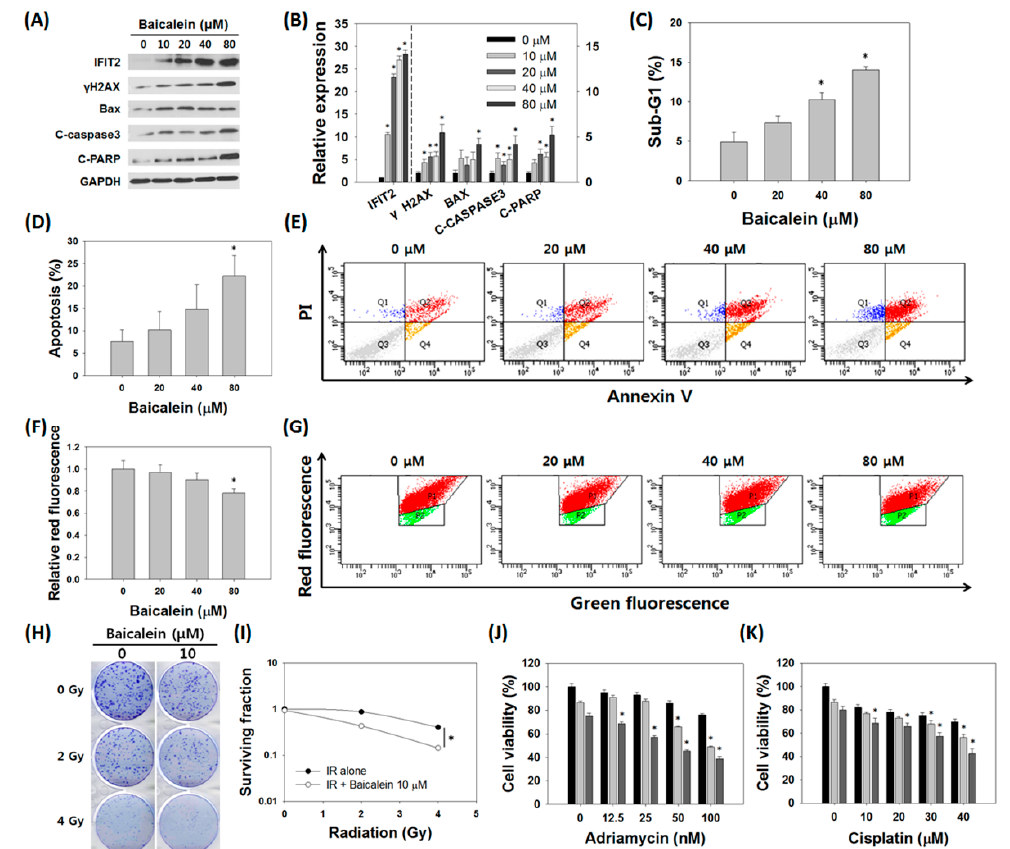
Figure 6. Baicalein induced apoptosis and sensitized resistant MDA-MB-231/IR cells. ( A , B ) Expression levels of IFIT2 (left-hand y -axis) and apoptosis marker proteins (right-hand y -axis) after baicalein treatment for 24 h. ( C ) Cell cycle analysis, ( D , E ) annexin V/PI staining, and ( F , G ) JC-1 staining were performed to observe induction of apoptosis by baicalein. ( H , I ) Baicalein sensitized MDA-MB-231/IR cells to irradiation. ( J , K ) Baicalein sensitized MDA-MB-231/IR cells to Adriamycin (0, 12.5, 25, 50, and 100 nM) and cisplatin (0, 10, 20, 30, and 40 μ M) treatment ( ▬ : Adriamycin or cisplatin alone, ▬ : Adriamycin or cisplatin with baicalein 10 μ M, ▬ : Adriamycin or cisplatin with baicalein 20 μ M). Asterisks (*) indicate significant differences at p < 0.05.